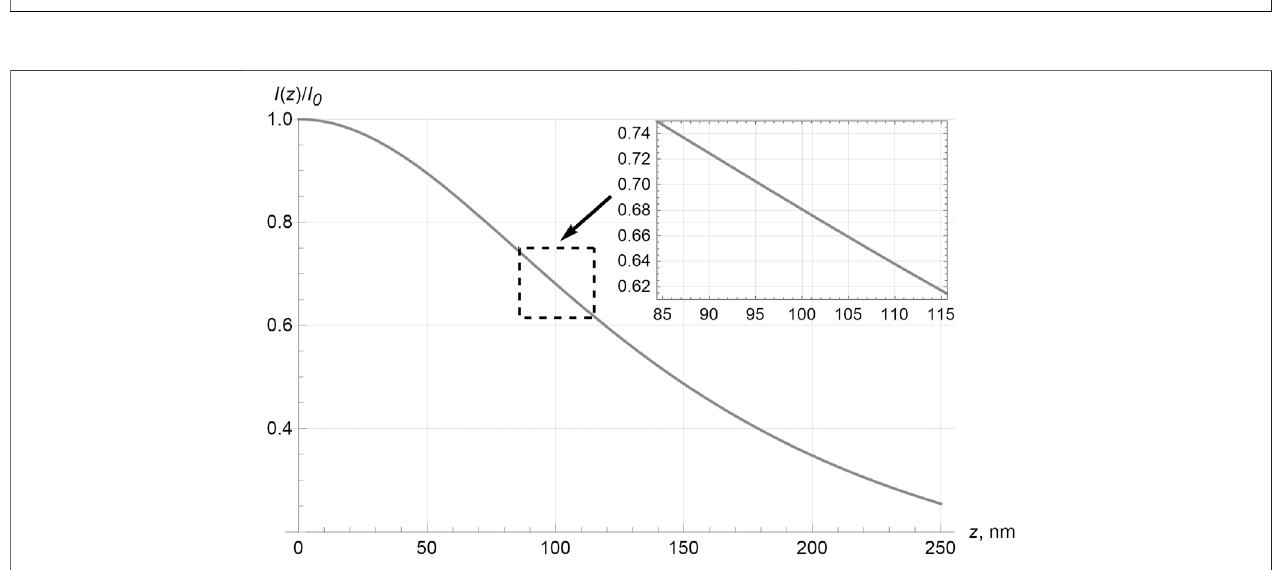
FIGURE5| Dependenceoftheexcitingbeamintensityonthedistancefromthewaistofthefocusedexcitingbeam.Inset:magni fi edregionofthedependencenear the distance 100 nm.